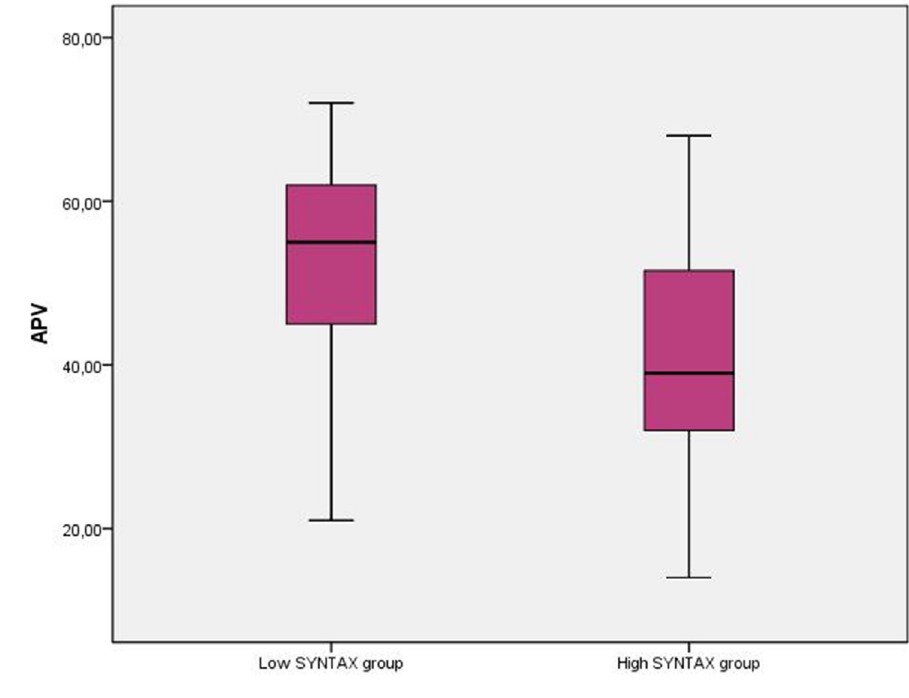
Fig. 2. APV values from low and high SS groups. APV, aortic propagation